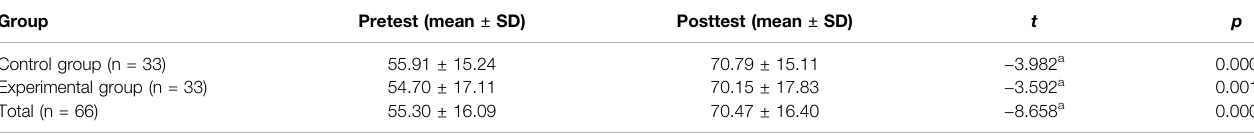
TABLE 4 | The comparison table of pretest and posttest data. Group Control group (n (cid:1) 33)